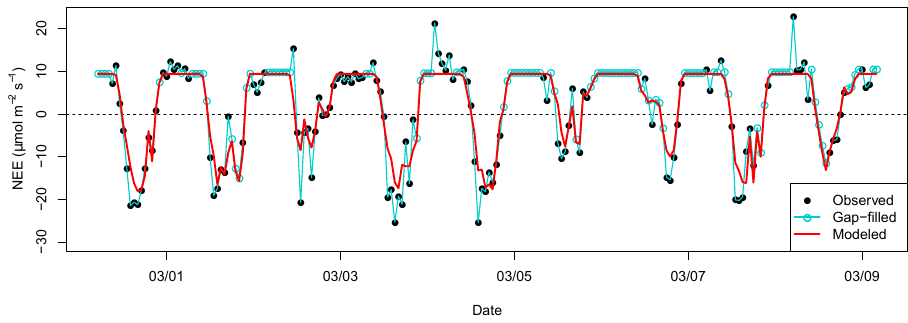
Figure 4. Example time series of NEE obs and NEE Model for 9 days of the wet season in 2008. Pearson correlation coefficient between NEE obs and NEE Model is R = 0 . 90 over the entire 7.5-year time series. Table 1. Model parameter values (95% confidence intervals in parentheses) and R 2 fit. Parameters have the following units: a 0 , a 1 , and a 2 :